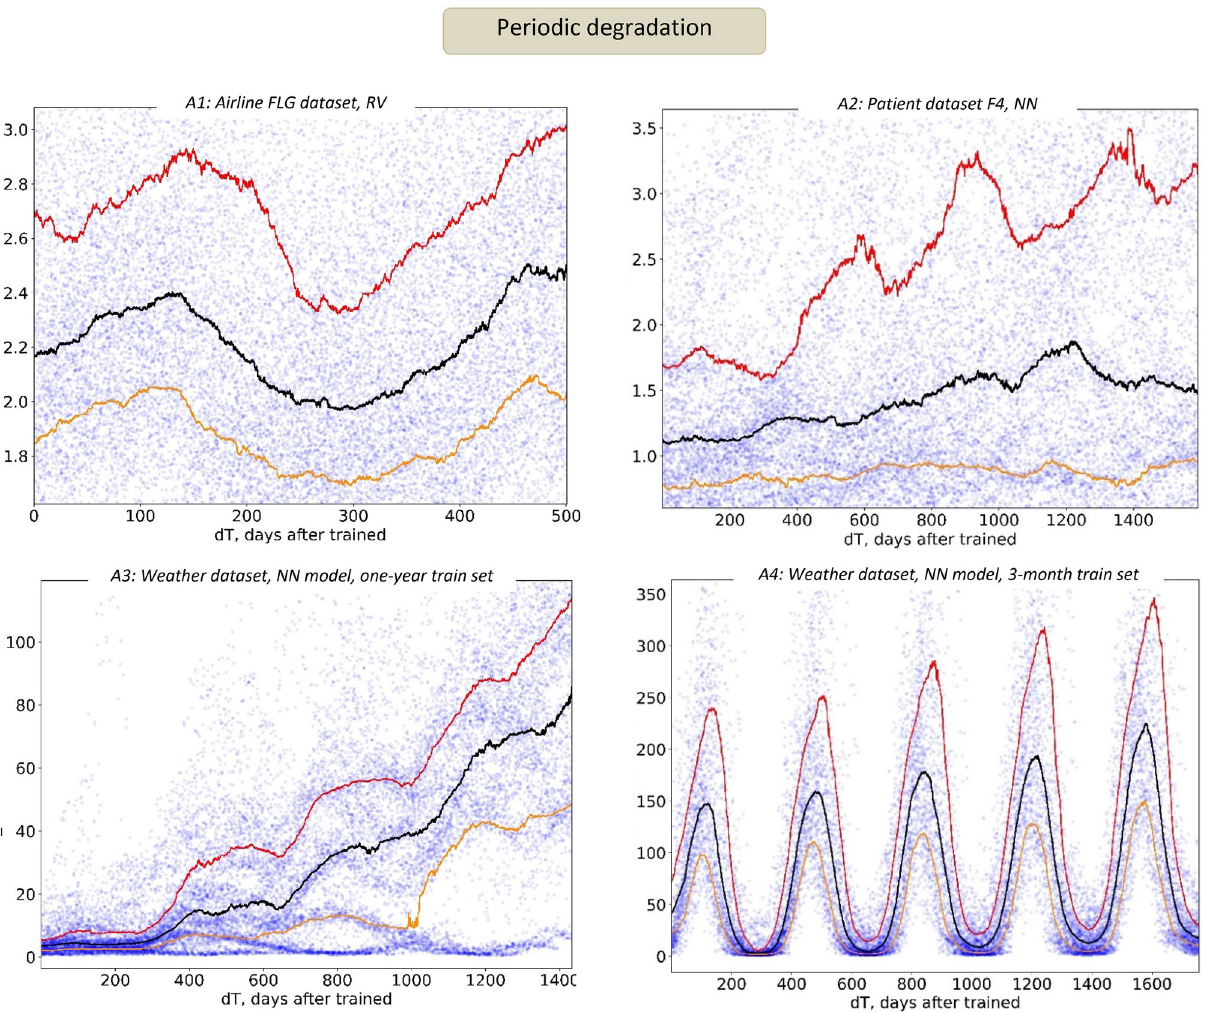
Figure 7. Periodic temporal degradation in AI models. Note how using different sizes of the train set affects periodicity in the model error (bottom